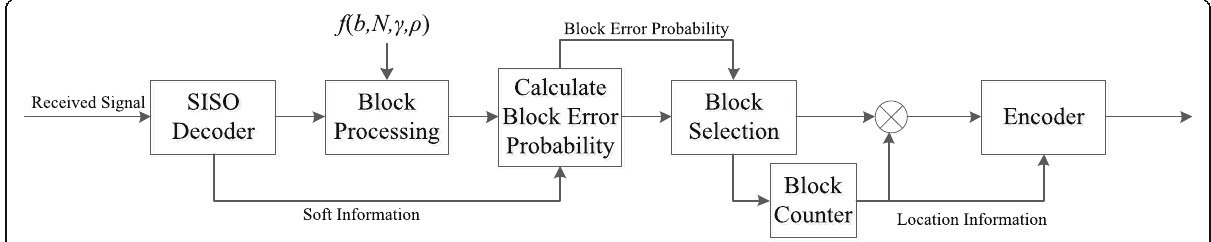
Fig. 3 Partial transmission at relay. The figure shows the detailed partial transmission at relay. After the relay received signal, it uses the SISO decoder to calculate the soft information of each bit, then the block error probability in the third step. The relay can also get the optimal block size with the information bits, the received SNR, and the average channel gain in the second step. Using the calculation results, several blocks with lower error probability are selected, then encoded with their location information, where the location information is encoded in the